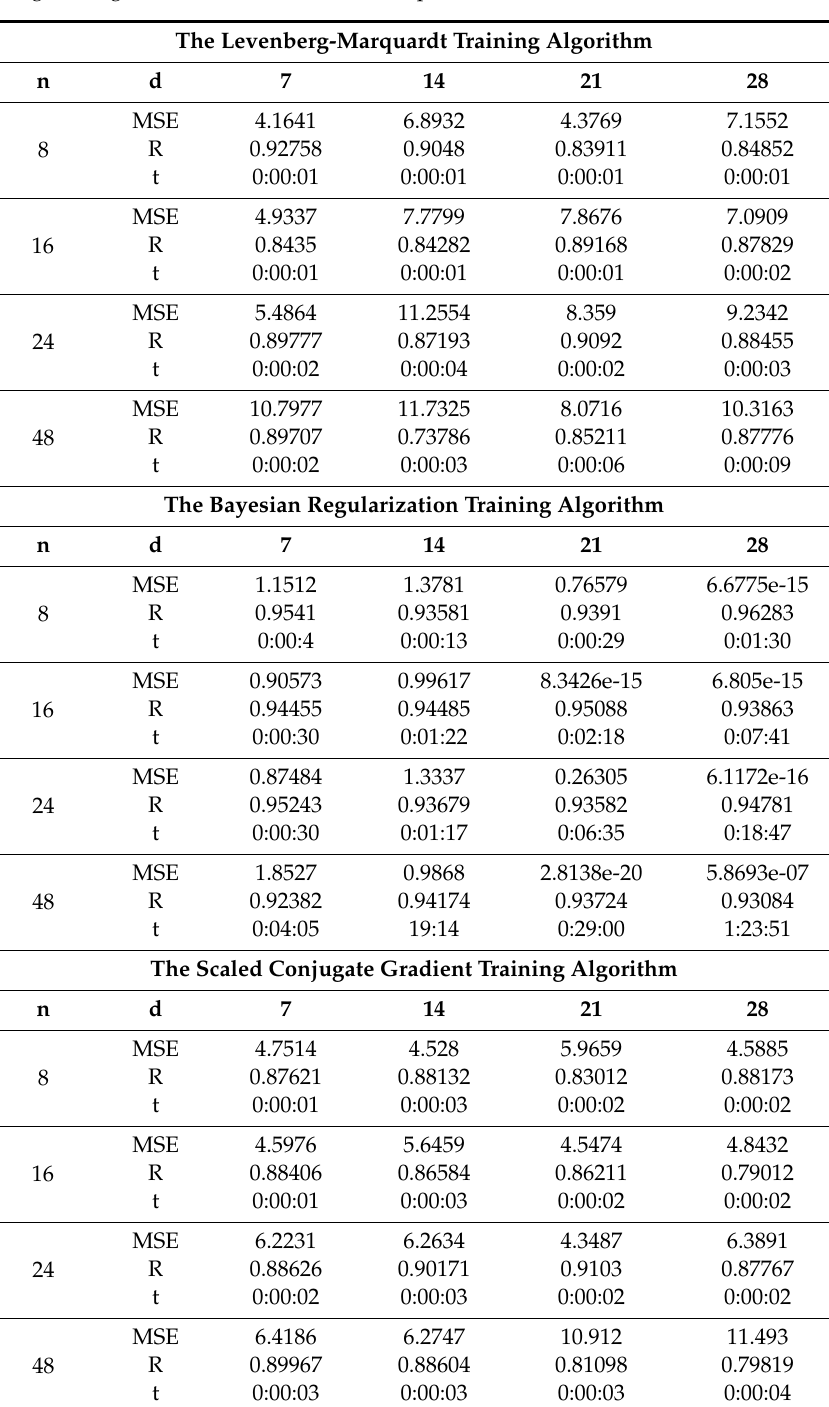
Table 1. The synthesis of the experimental results when developing the artificial neural networks (ANNs) forecasting solution based on the non-linear autoregressive with exogenous inputs (NARX) model, using as exogenous variables the time stamps